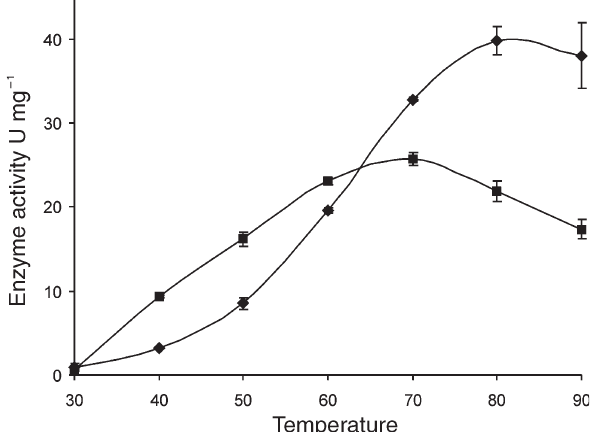
Figure 3. Temperature dependent activity of purified SacKdgA wild type ( (cid:2) ) and SacKdgA-V193A ( (cid:3) ). Activities were determined in 50 mM sodium phosphate buffer (pH 6.0), 10 mM pyruvate and 20 mM